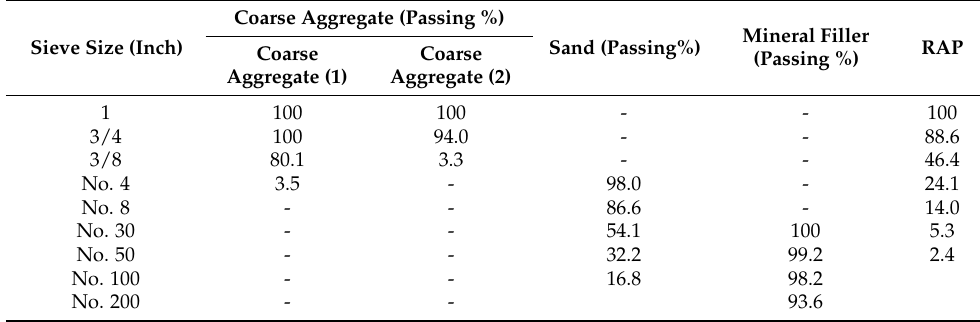
Table 3. Gradation of coarse aggregate, sand, mineral filler, and